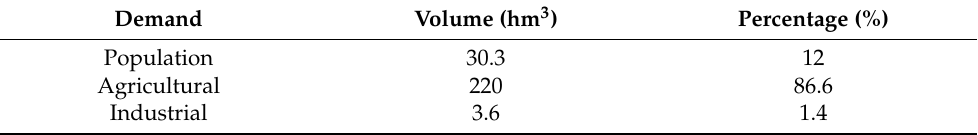
Table 7. Actual demand in the VUB